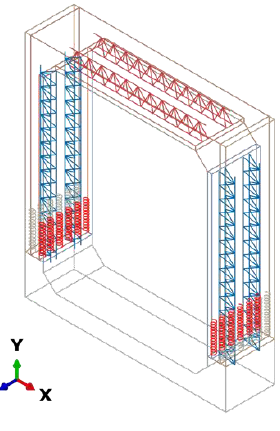
Figure 5. Finite element model.